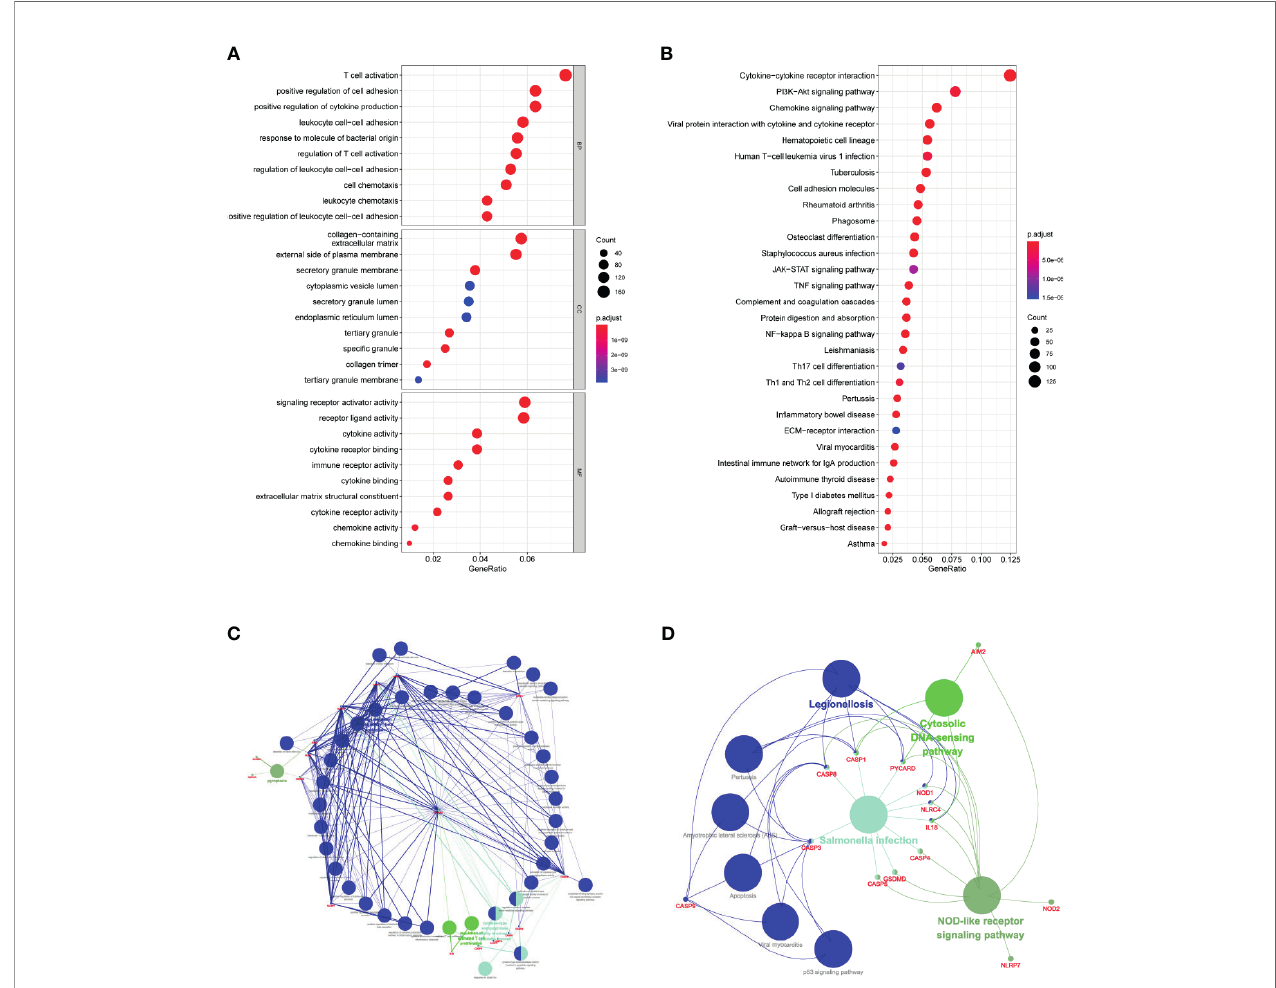
FIGURE 7 | Functional analysis based on the DEGs between the two-risk groups in the TCGA cohort. (A) Analysis of GO enrichment for DEGs. (B) Analysis of KEGG enrichment for DEGs. (C) Result of ClueGO GO : BP enrichment. (D) Result of ClueGO KEGG pathway